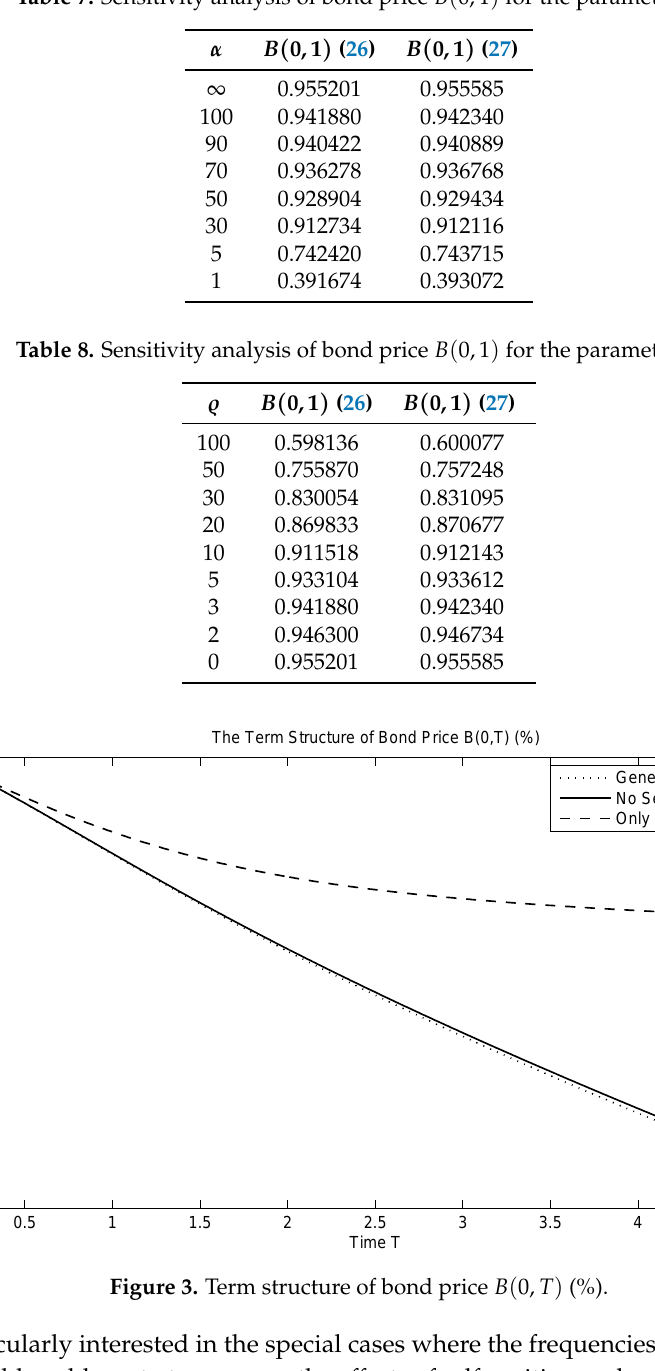
Table 7. Sensitivity analysis of bond price B ( 0,1 ) for the parameter α .